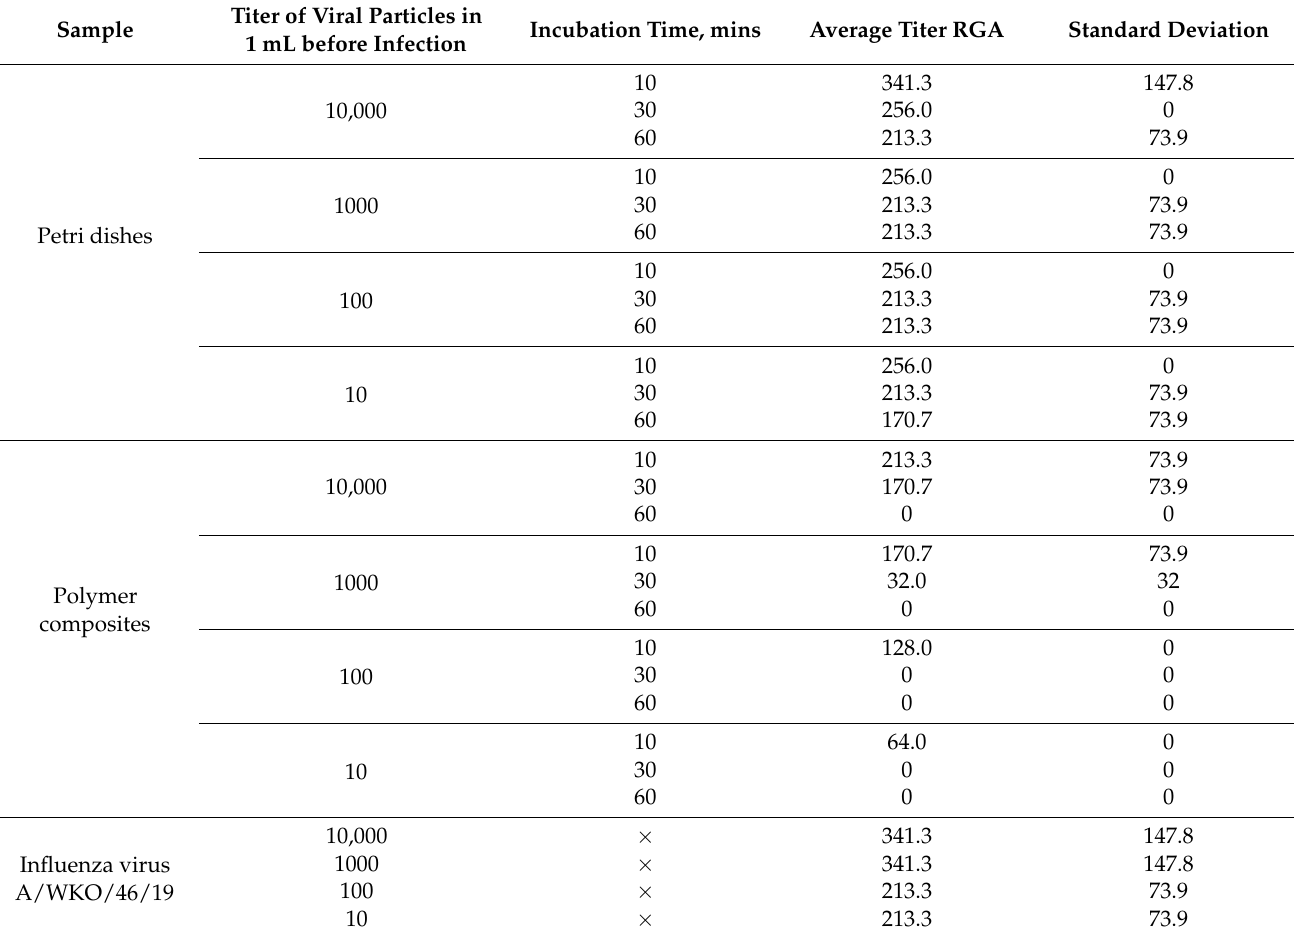
Table 9. Determination of the presence of influenza virus A/WKO/46/19 in allantois using